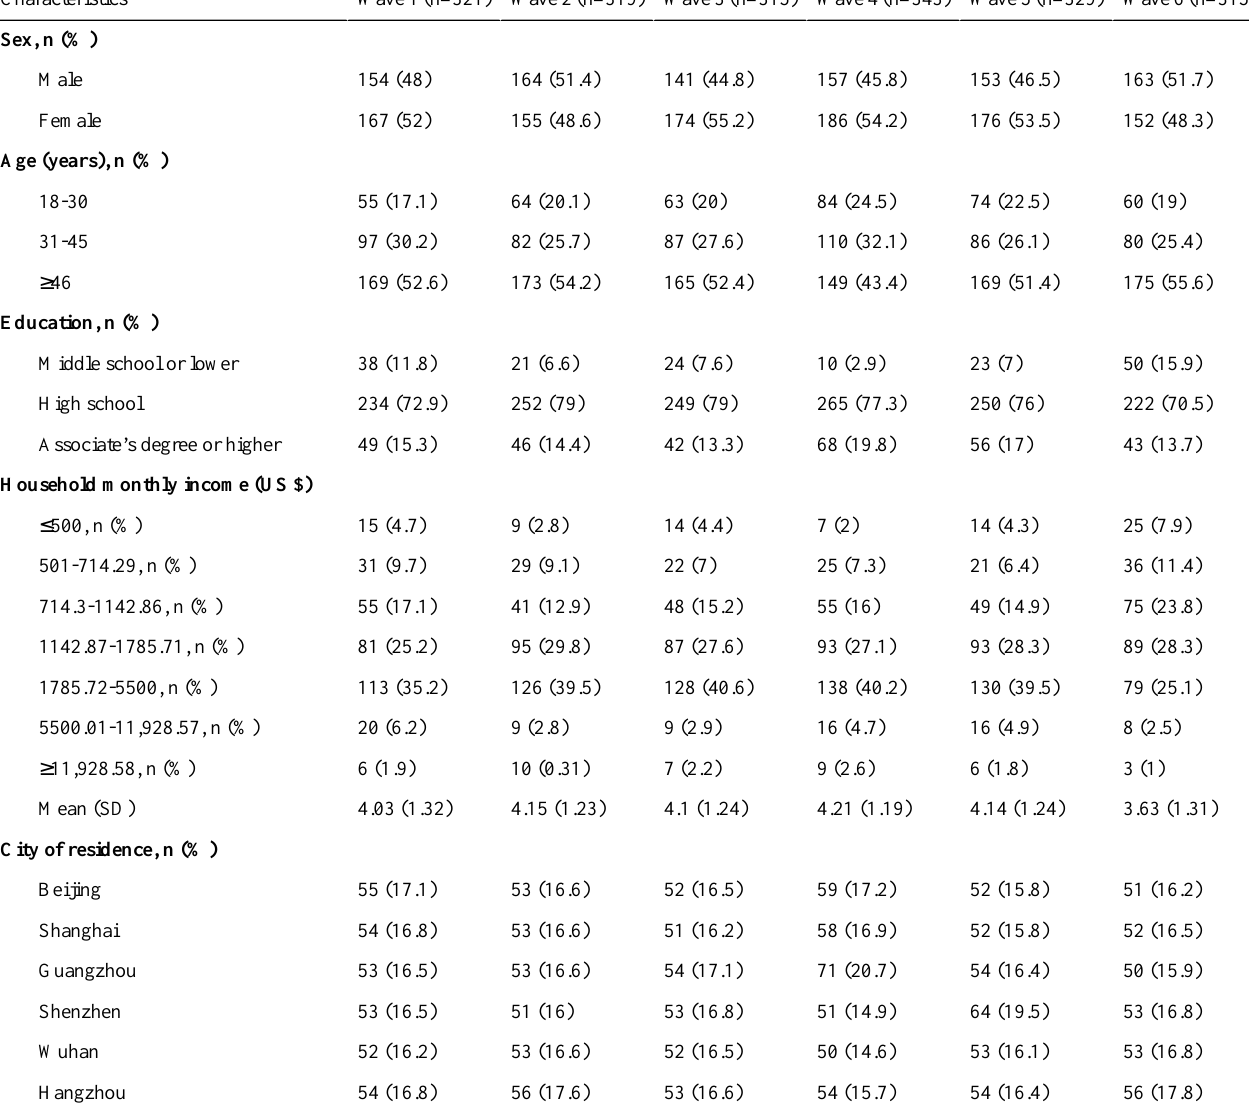
Table 1. Sample characteristics across